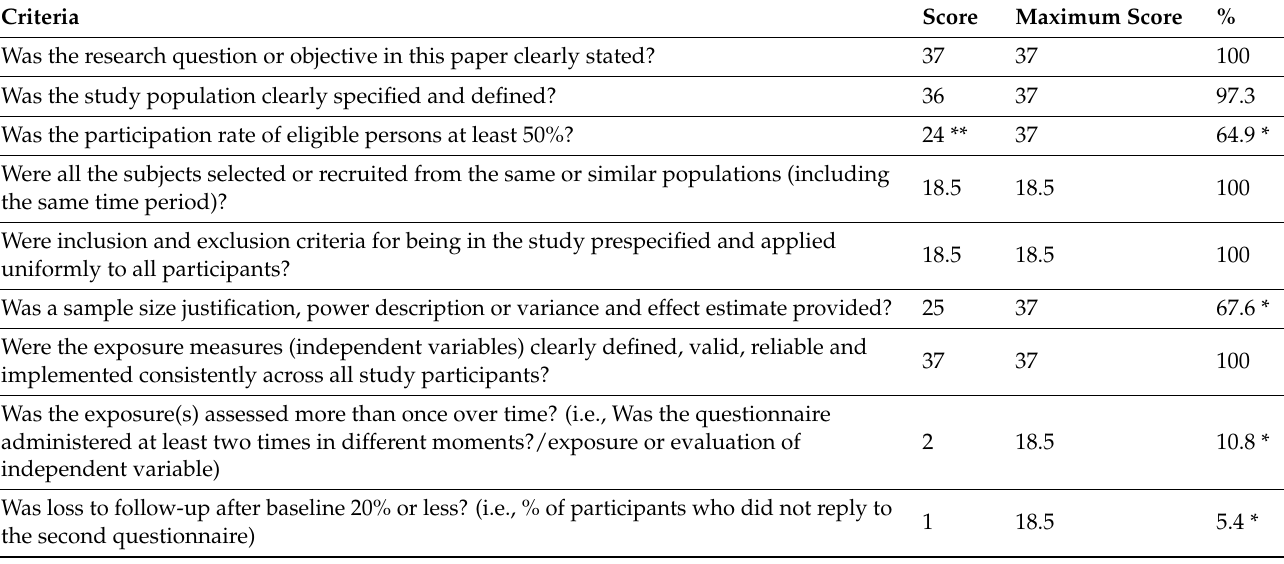
Table 4. Quality assessment of the 37 selected studies with the NHLBI tool